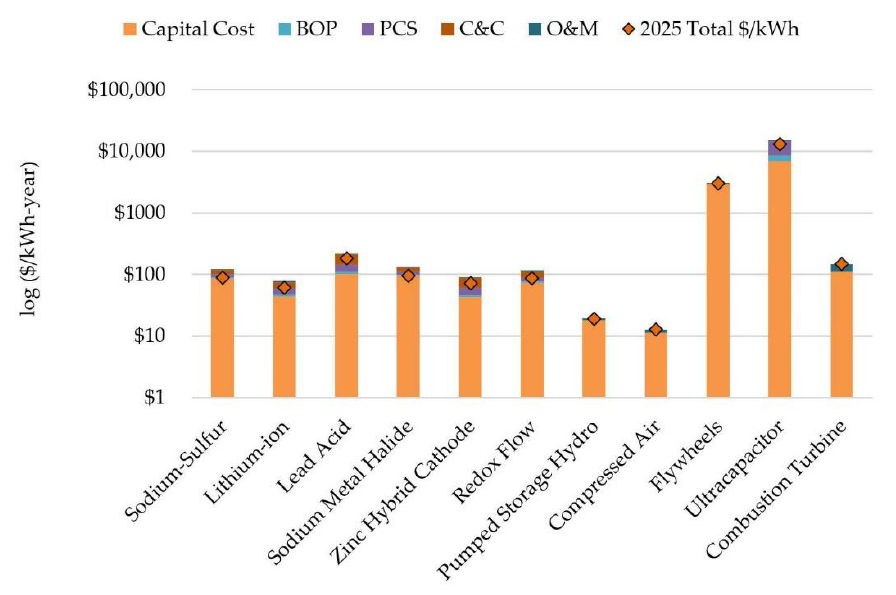
Figure 5. Annualized costs for each technology by cost component, 2018 and 2025 ($/kWh). Table 38. Annualized costs for each technology, 2018 and 2025 ($/kWh).